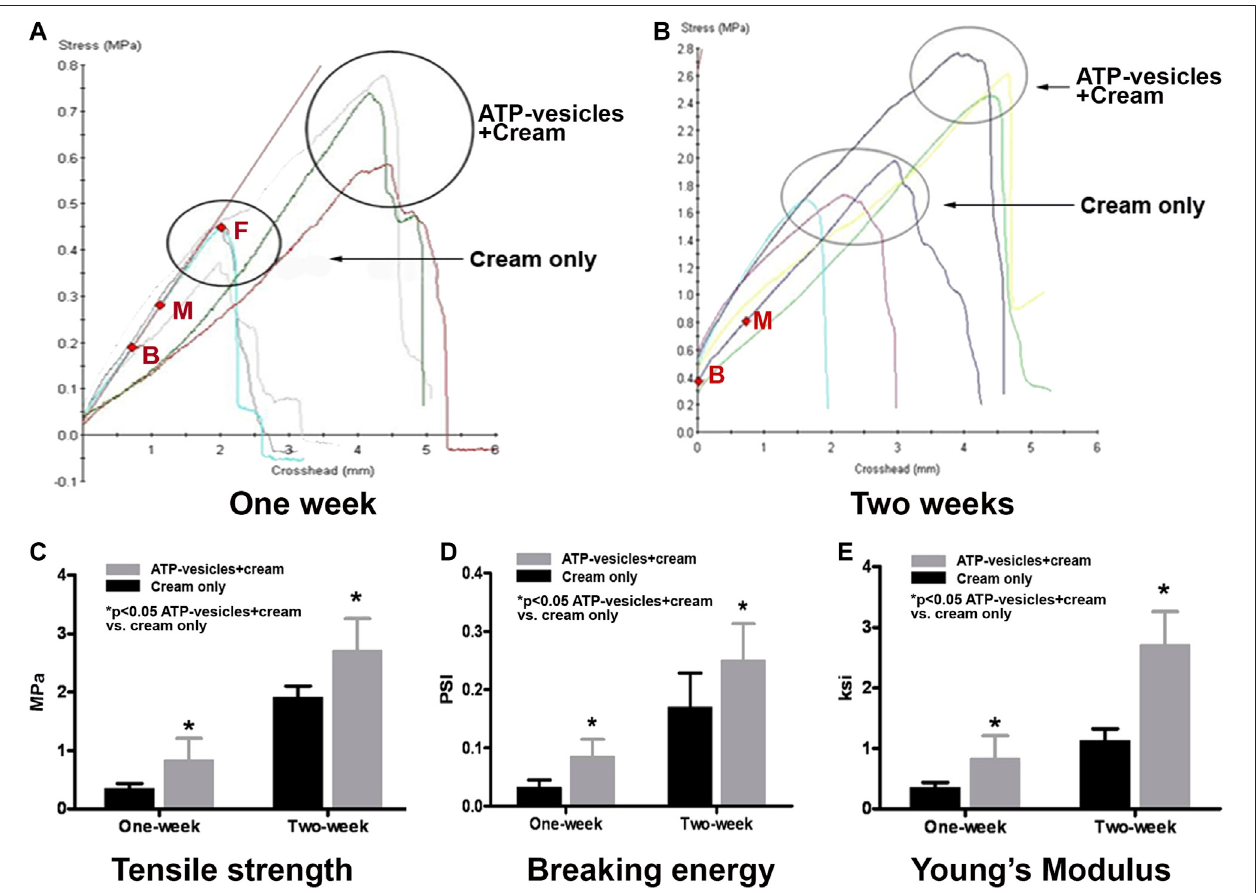
FIGURE3| Biomechanicaltestingofwoundtissues. (A) .Atpostoperativeday7.Tissuetensilestrengthhasalinearrelationshipbetweenloadandelongationofthe tissueuptothepointofpeakstress(frompointBtopointM).Afterthatpoint,therelationshipisnolongerlinearbutbreakagedoesnotoccuruntilfurtherstretching(point F). (B) .Atpostoperativeday14,woundshavehighertensilestrengththanatday7. (C) .Statisticalcomparisonofwoundtissuetensilestrengthbetweentheexperimental and control groups at postoperative days 7 and 14. (D) . Comparison of wound breaking energy at postoperative days 7 and 14. At postoperative day 7, the breakingenergy intheexperimental woundswas198%ofthevalue forthecontrolwounds. Atpostoperative day14, thebreakingenergy intheexperimental groupwas 147% of the value for control wounds. (E) . Comparison of Young ’ s modulus (stress/strain, within elastic limit; i.e., Hooke ’ s law) of wound tissues between the two groups; the average value at postoperative day 7in the experimental wounds was242% ofthe value for the control wounds. Atpostoperative day 14, the average value in the experimental wounds was 249% of the value for the control wounds (Note: 1 psi (cid:1) 6.895 MPa (cid:1) 0.703 g/mm 2 ).